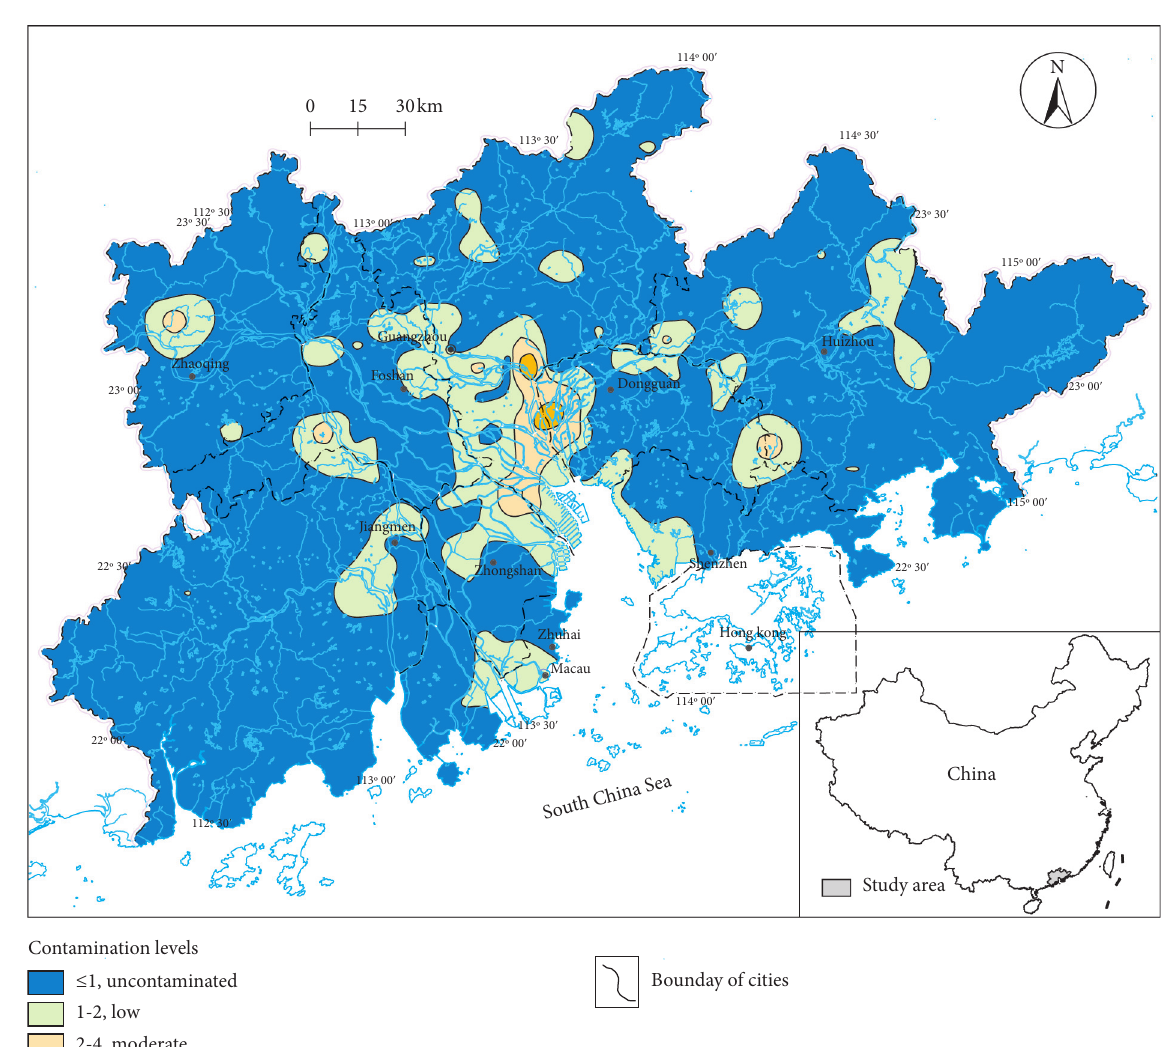
Figure 4: Spatial distribution of groundwater salinity contamination in the Pearl River Delta.